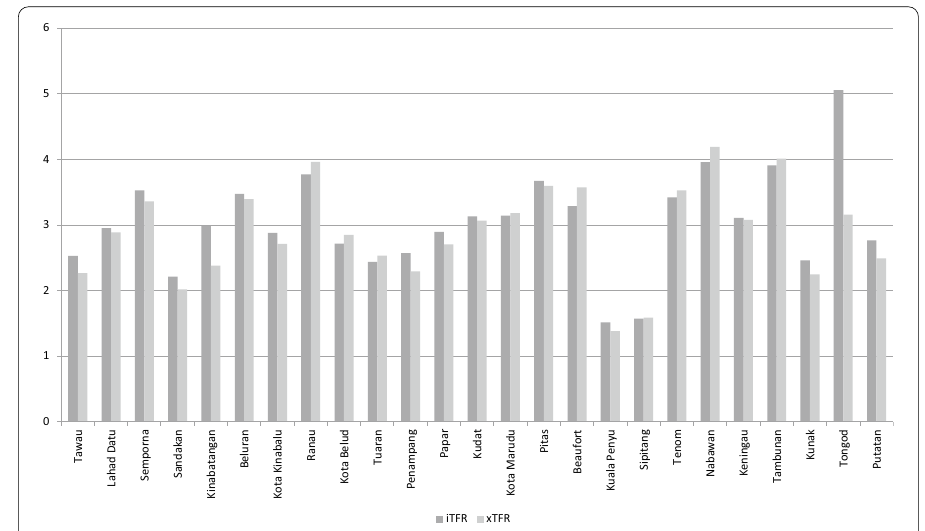
Fig. 6 iTFR and xTFR by district in Sabah, 2010. The iTFR and xTFR were computed using Eqs. (3) and (4),